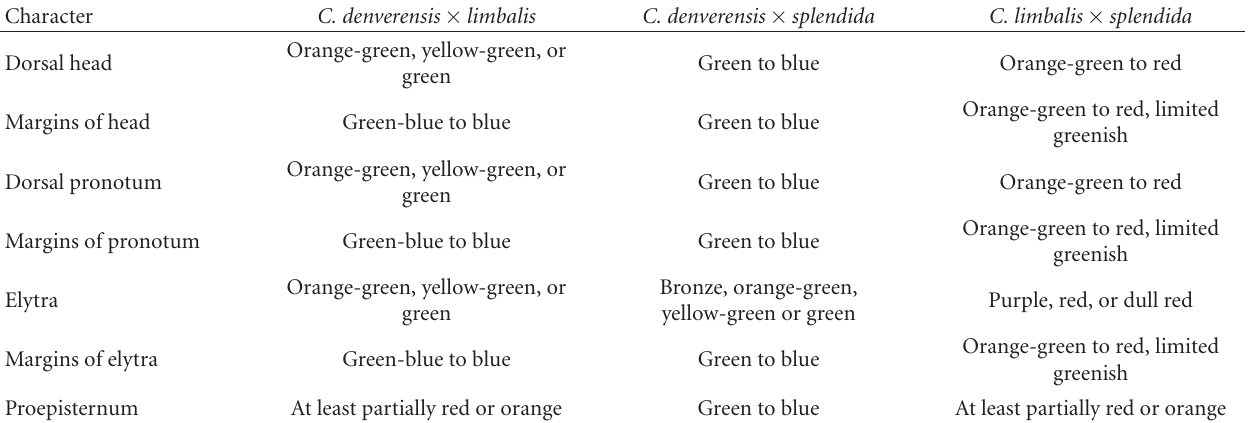
Table 6: Variations in color found in apparent hybrids between species in the Cicindela splendida group.